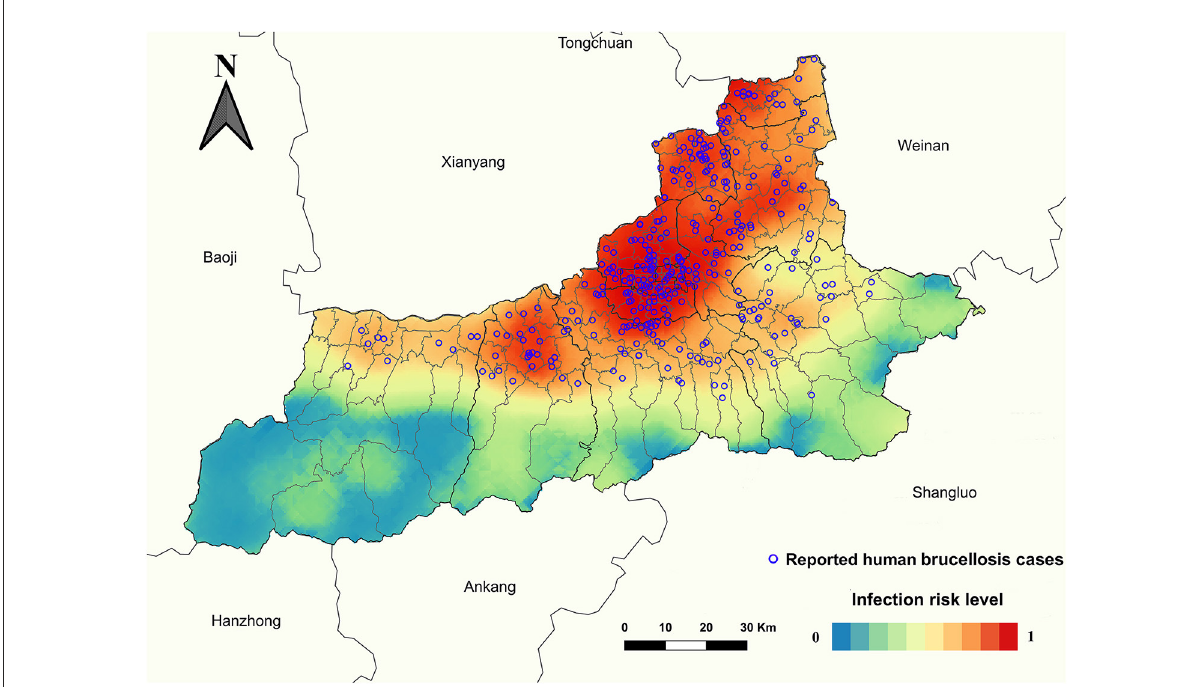
FIGURE5 Predicted risk map of human brucellosis in Xi’an. The map was created using ArcGIS 10.2 software, ESRI Inc., Redlands, CA, USA, by the kriging interpolation